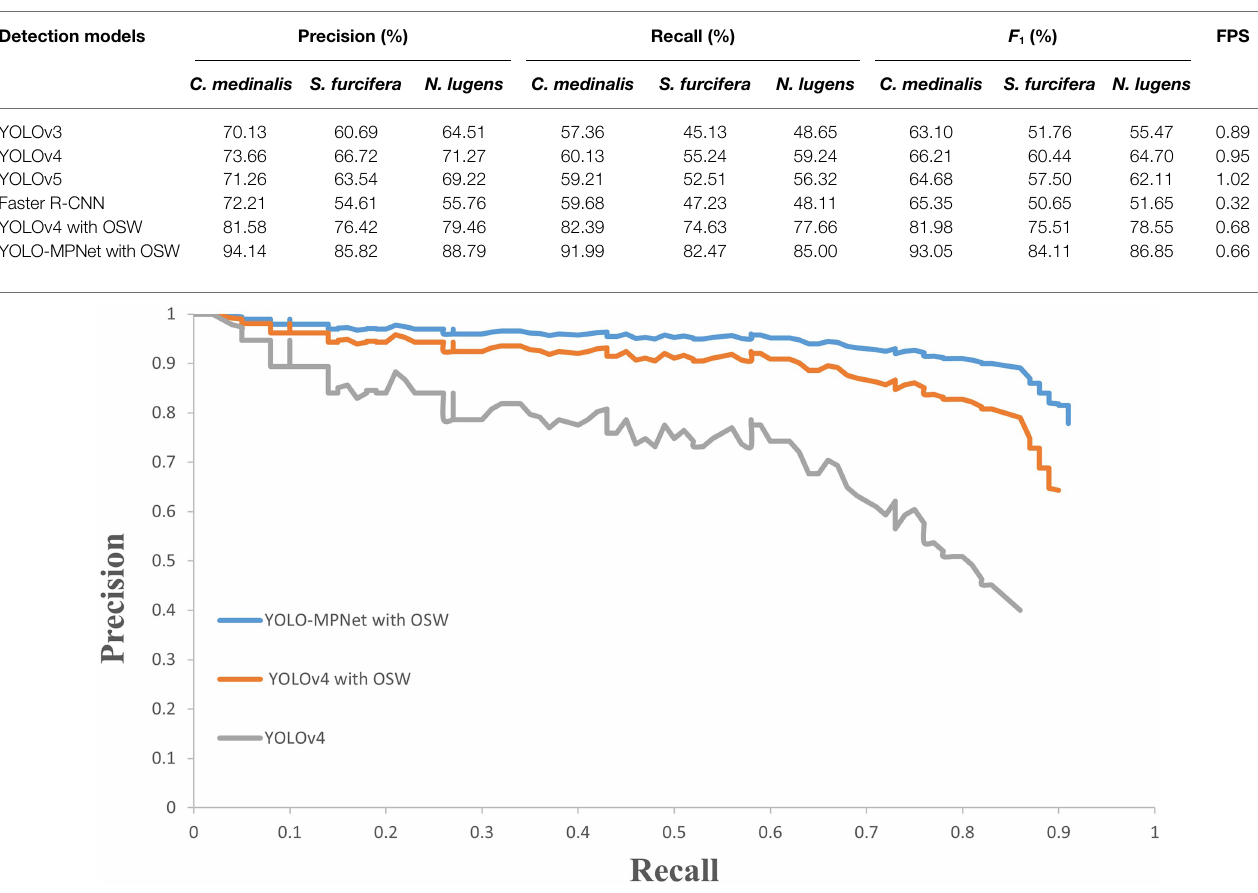
FIGURE 5 | PR curves for different models.